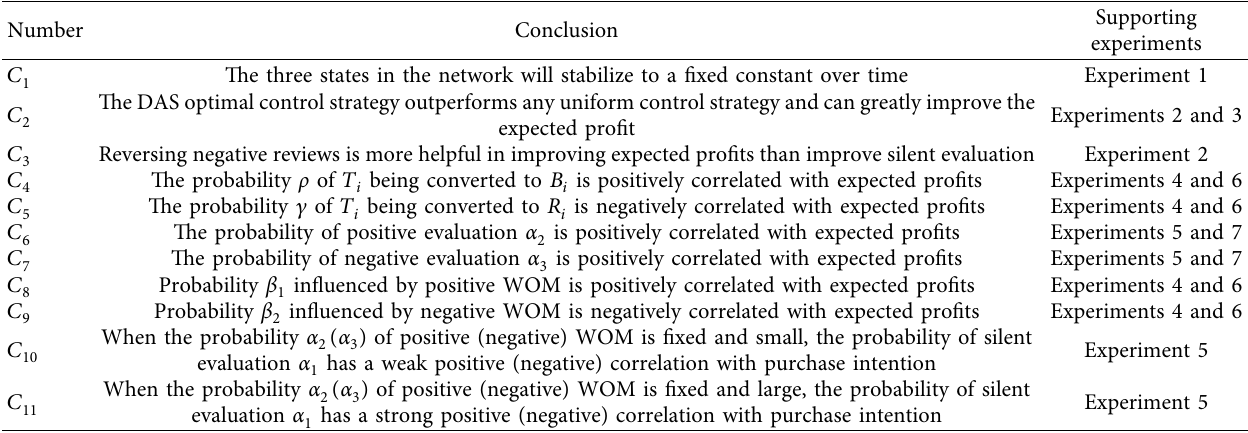
Table 4: Summary of experimental